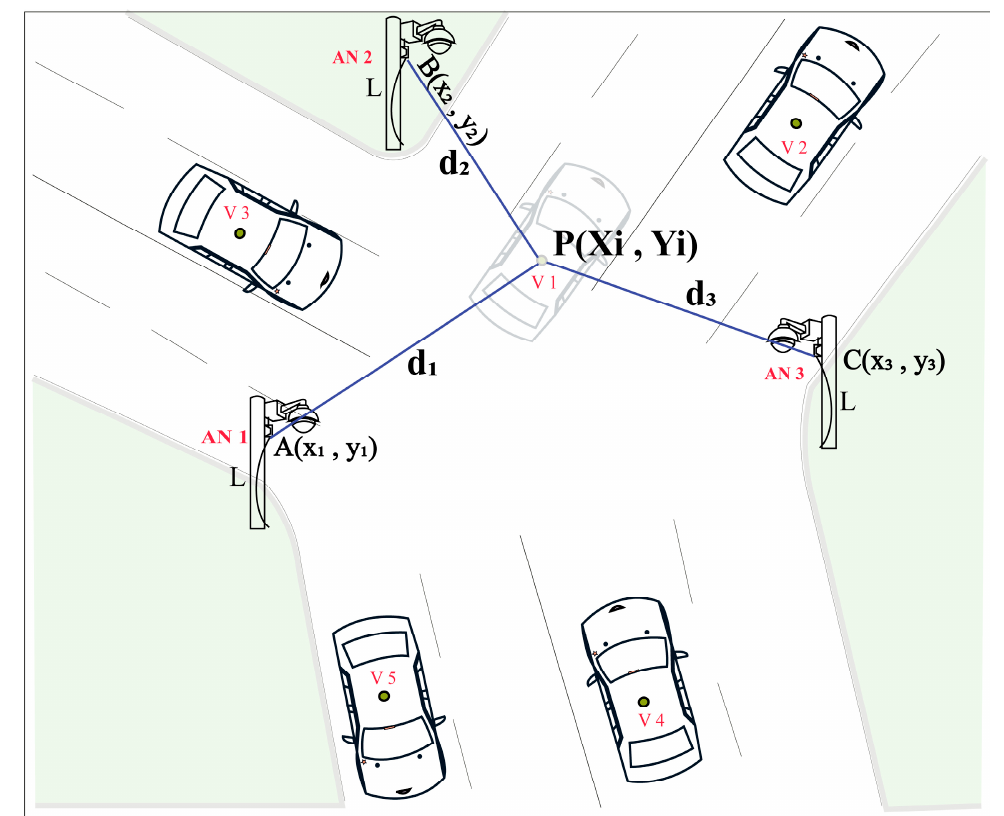
Figure 10. Proposed localization model of AV’s positioning by multi-anchor nodes tra ffi c surveil- lance system. lance